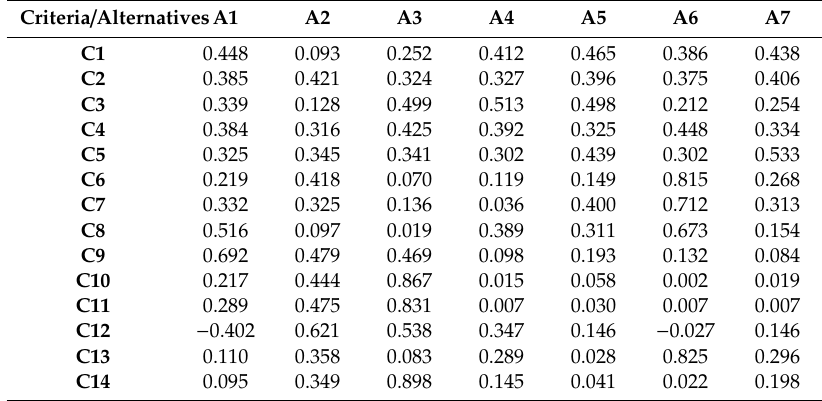
Table A5. Dimensionless numbers for the